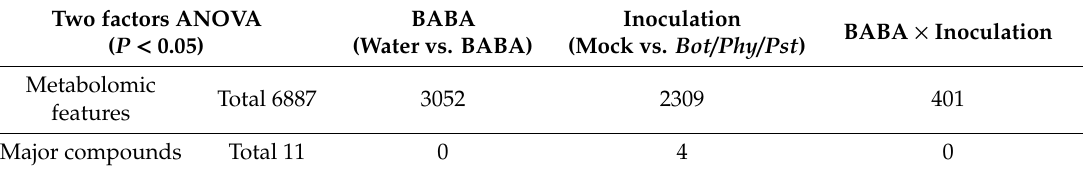
Table 1. Univariate statistical analysis of the metabolomic features and major compounds.